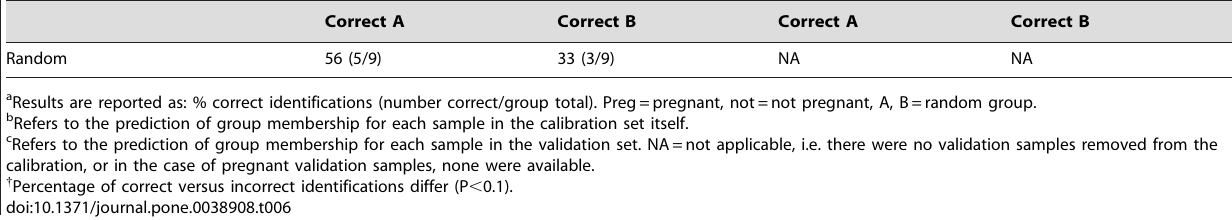
Pregnant vs. Not